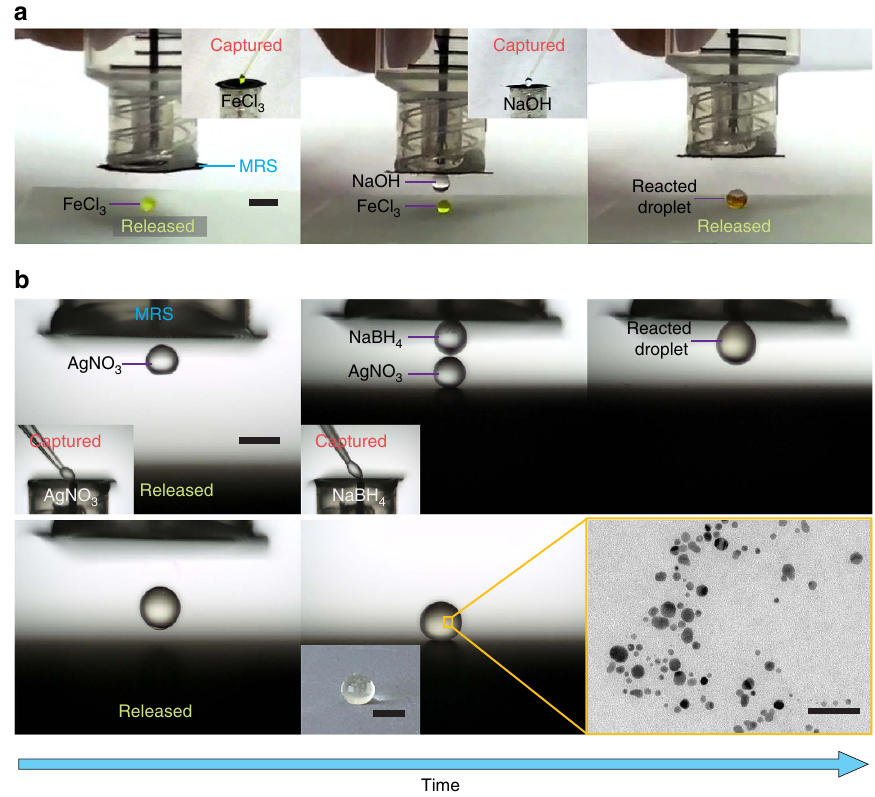
Figure 6 | MRS-assisted micro-reactors. ( a ) Time-sequence images showing an MRS-based process using droplet-based micro-reactors for the generation of Fe(OH) 3 precipitates. Scale bar, 3mm. ( b ) Time-sequence images showing an MRS-based process using droplet-based micro-reactors for the synthesis of silver nanoparticles. Scale bars, 2mm. Also presented in a transmission electron microscopy image showing the synthesized silver nanoparticles. Scale bar, 50nm.